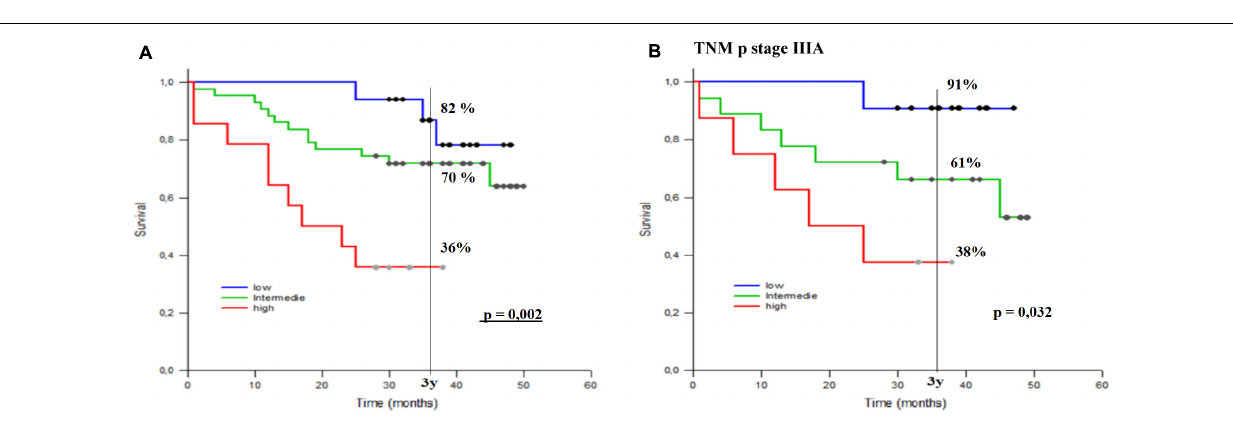
positively with survival and this correlation remained significant across different stages (26). In the same way, we could not confirm the negative prognostic value of high PD-L1-expressing